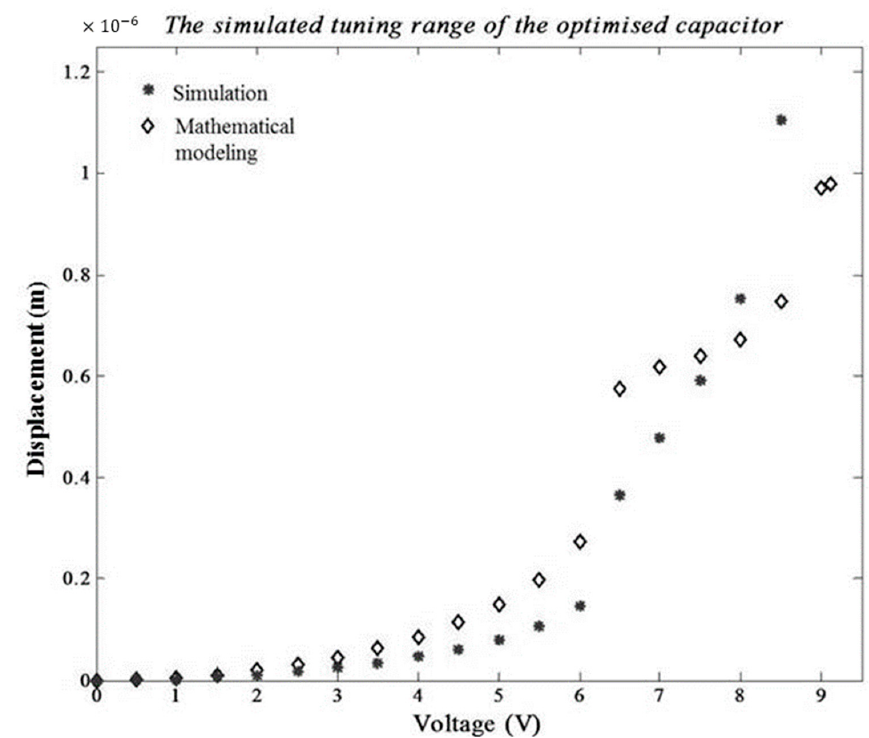
Figure 6. Static structure the analysis of the optimized capacitor. Figure 7 represents the displacement result of the comparison with theoretical data and simulations for the mechanical behavior analysis of the optimal MEMS capacitor within the input voltage range from 0 V to 9.5 V.